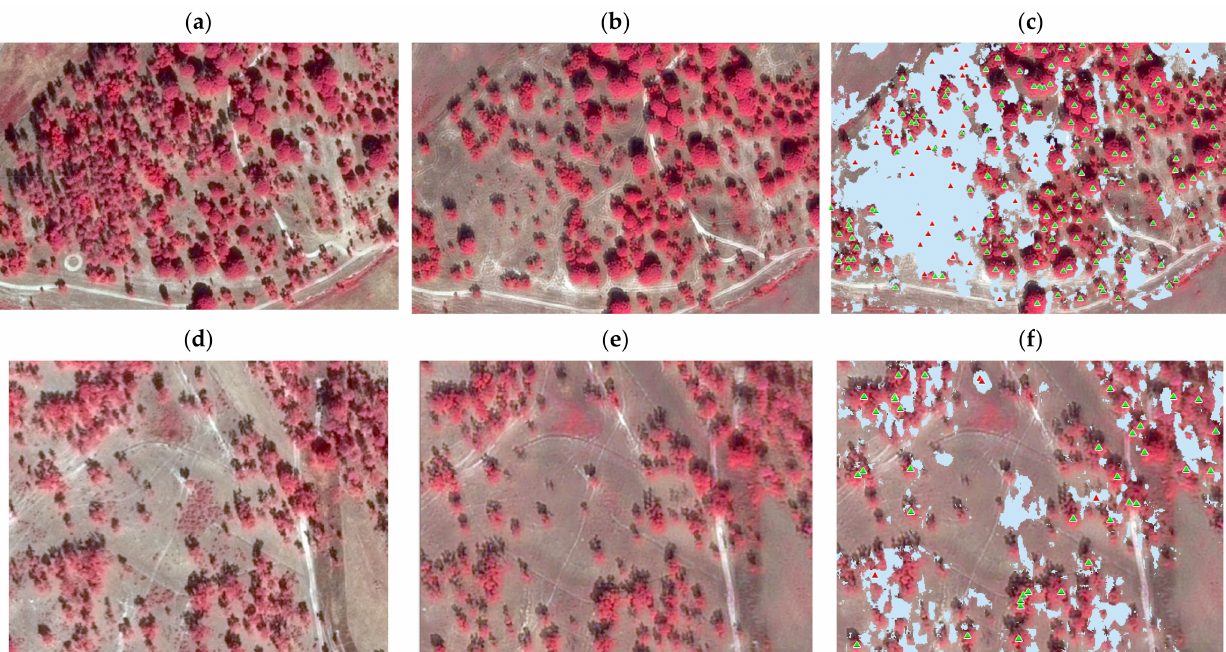
Figure 9. Two examples of the dead tree detection approach: tree felling ( a – c ) and cork oak decline ( d – f ). False-color composite of the 2018 image ( a , d )—and of the 2020 image ( b , e ). The light blue mask ( c , f ) is the result of the “death tree” classification overlaid on the 2020